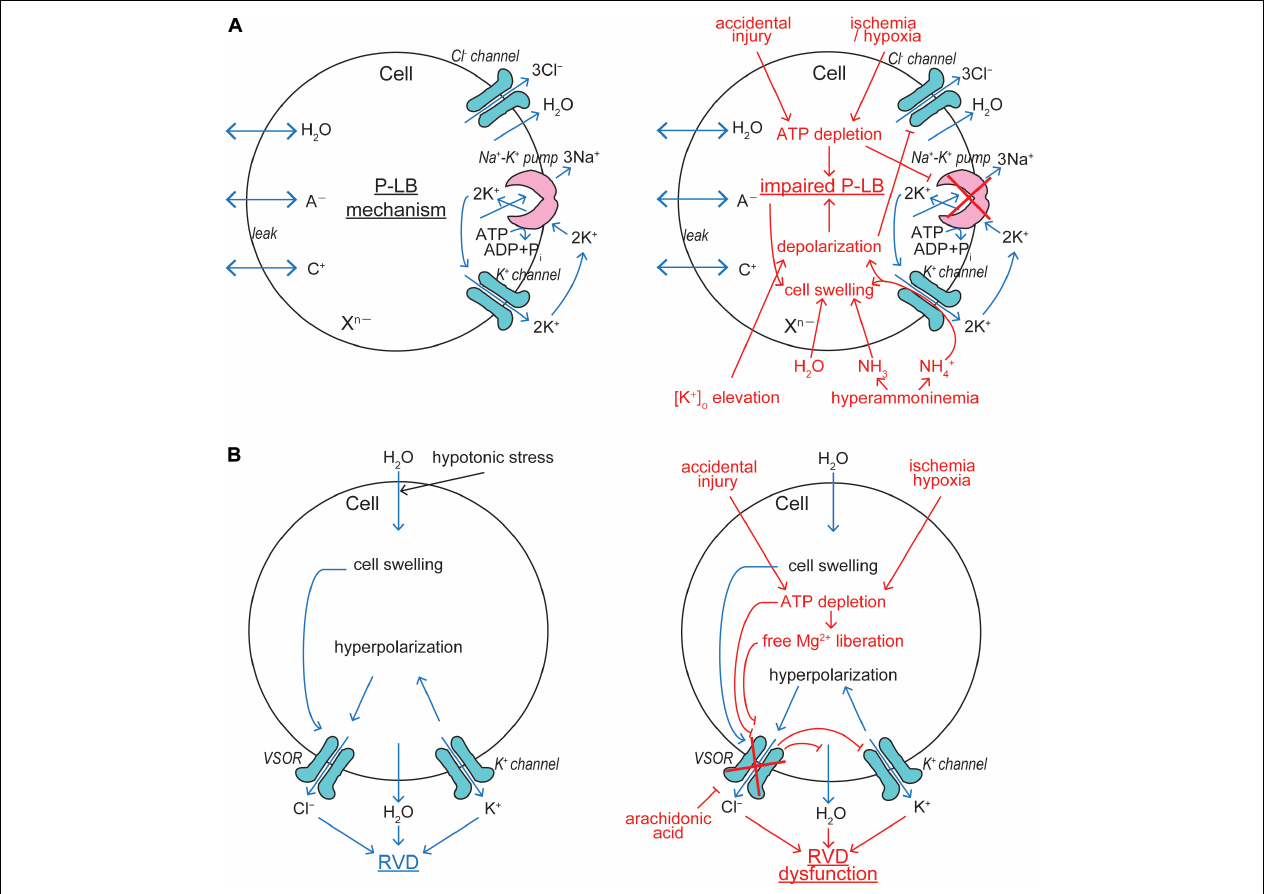
FIGURE 2 | VSOR/VRAC involvements in cell volume regulation/dysregulation. (A) The pump-leak balance (P-LB) mechanism coping with steady-state oncotic cell swelling (left panel) and its dysfunction leading to NVI (right panel). The Cl − channel involved in this mechanism is not identified as yet. (B) The RVD mechanism coping with non-steady state osmotic cell swelling (left panel) and its dysfunction leading to necrosis (right panel). VSOR plays a key role in this mechanism by sensing cell swelling (See the text for